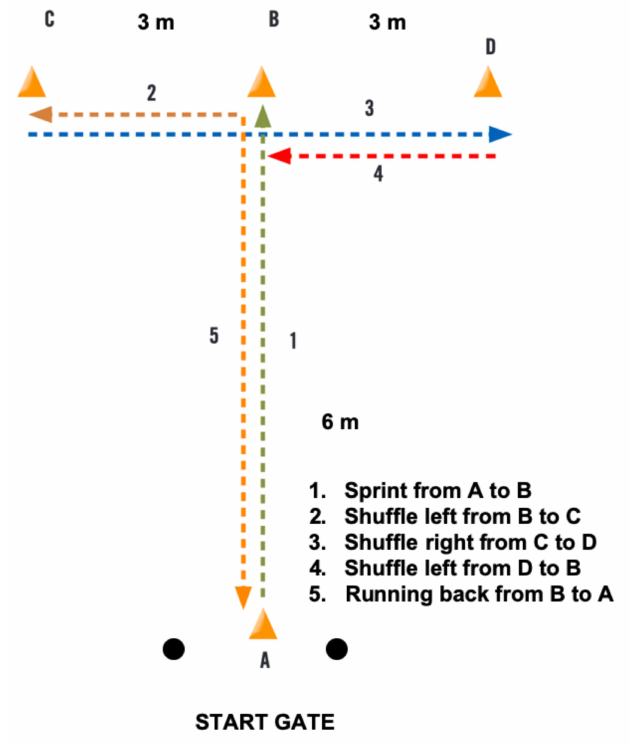
Figure 2. Set up of the modified T-test for agility